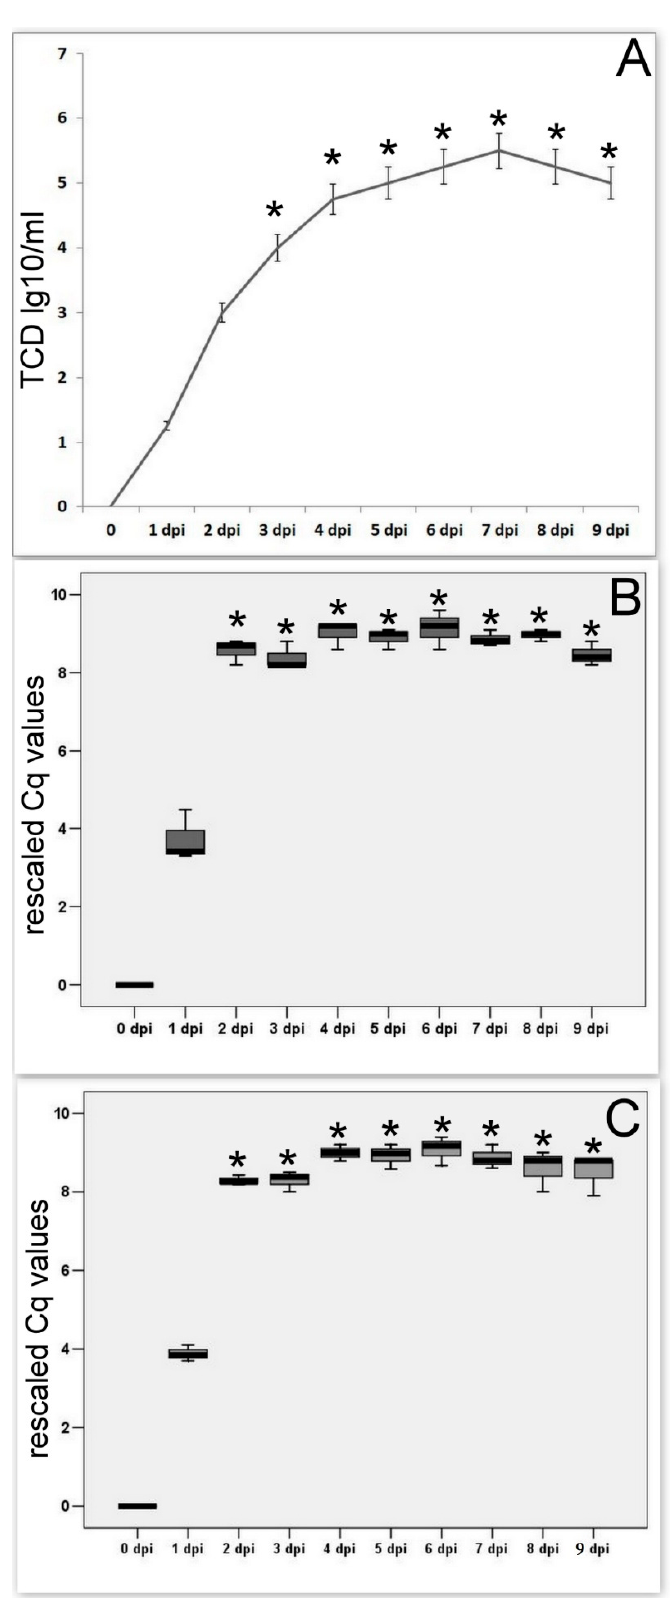
Figure 4. SARS-CoV-2 quantification in vitro. ( A ) Biological titration of SARS-CoV-2 on Vero E6 cells. ( B ) qRT-PCR detected levels of Nucleocapsid (N) Gene copies of SARS-CoV-2on Vero E6 cells. ( C ) qPCR levels of ORF1 copies of SARS-CoV-2 on Vero E6 cells.